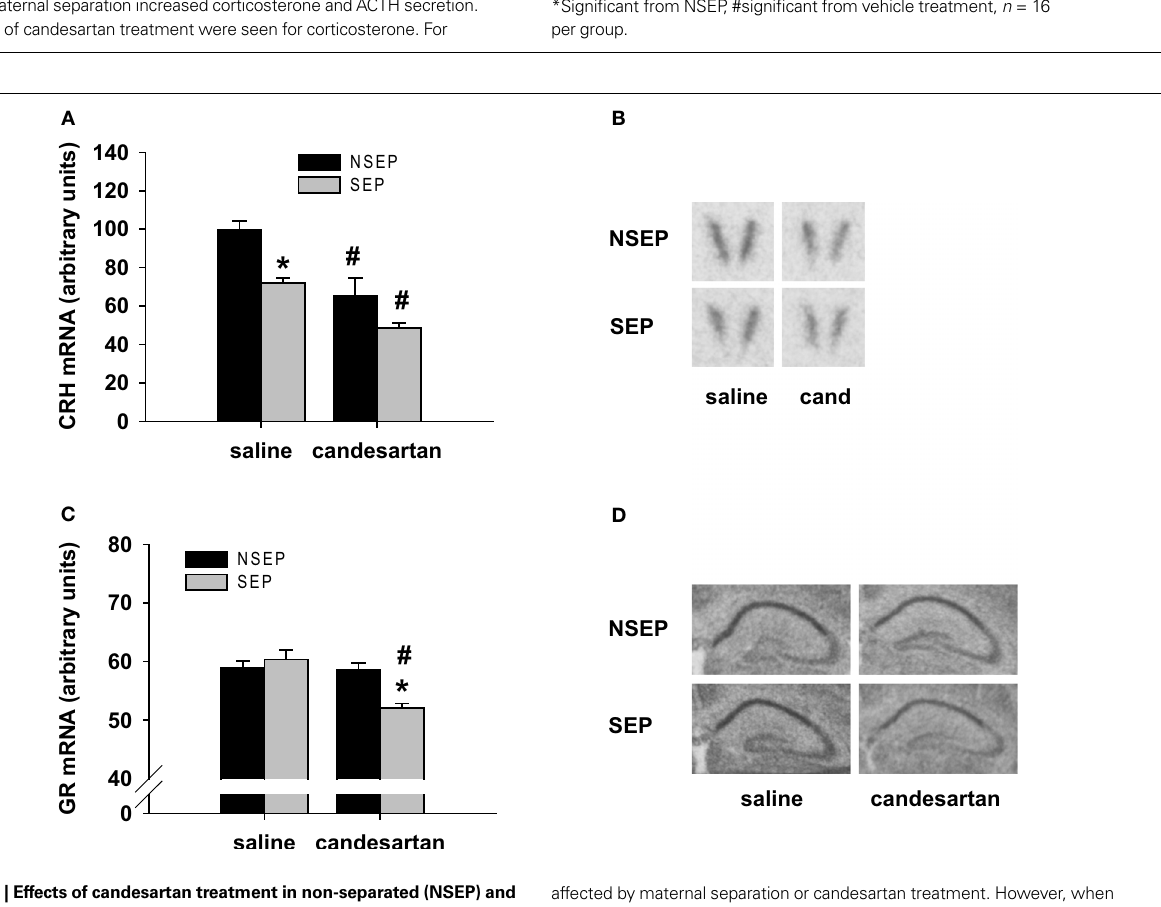
ACTH, candesartan treatment resulted in a signifi cant increase of ACTH secretion compared to vehicle-treated pups of the same condition.